Question: Describe this figure in one sentence.
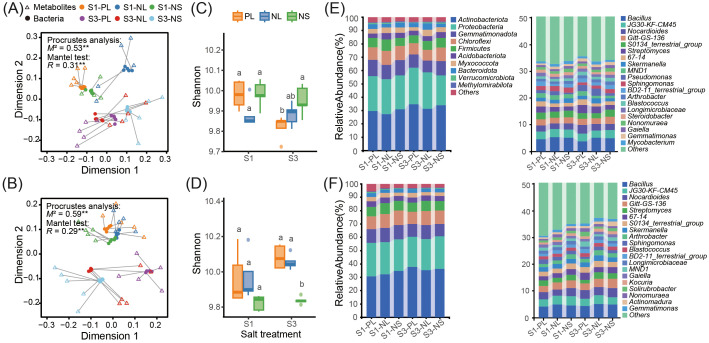
Answer: Rhizosphere bacterial communities. (A, B) Procrustes analysis and Mantel test assessing metabolite-microbiome correlations; (C, D) Bacterial community diversity indices; (E, F) Relative abundances of the top 10 bacterial phyla and top 20 genera. Panels (A, C, E) Soybean; Panels (B, D, F) Suaeda salsa . PL, Plastic barrier separation; NL, Nylon mesh separation; NS, No separation. Different lowercase letters in (C, D) indicate significant differences ( p = 0.05) among root interaction modes under the same salt treatment.